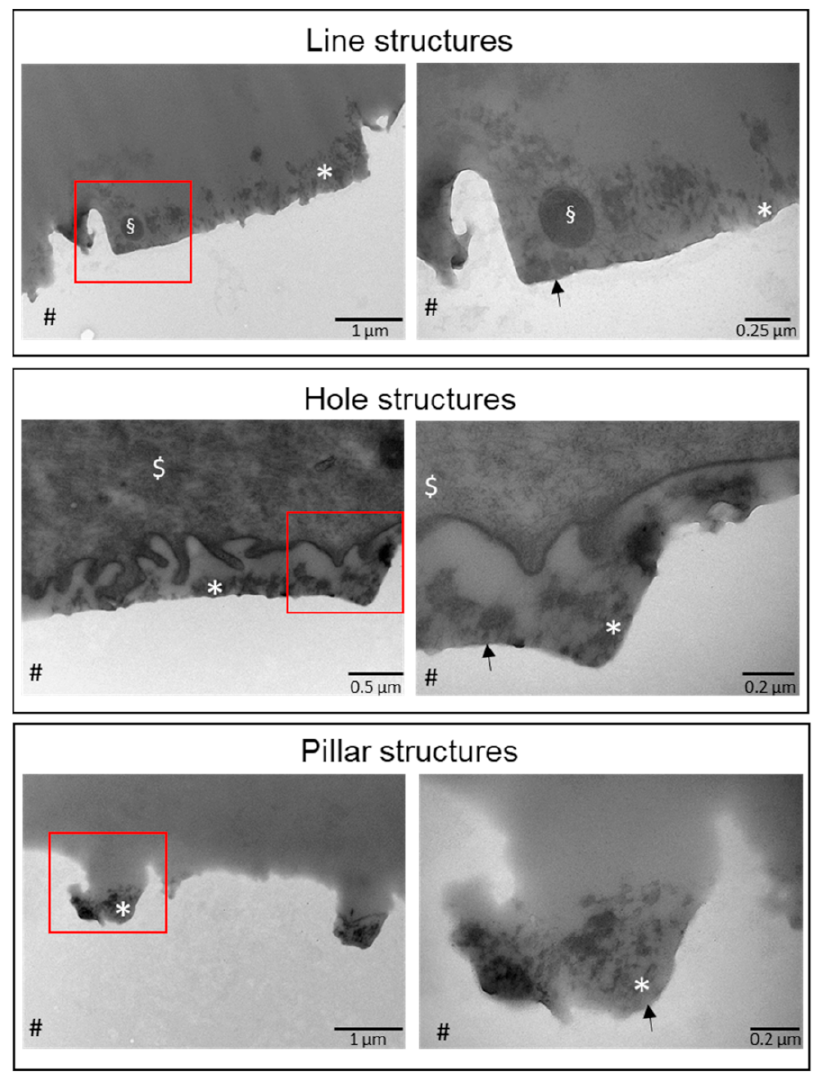
Figure 6. TEM images of specimens exposed to the oral cavity. Specimens made from PFPE containing lines, holes, or pillars were exposed to the oral cavity for 8 h. TEM images were prepared from the probes within the central area. Images on the left side show smaller magnifications while images on the right side depict larger magnifications of the area, indicated by a red square. # denotes the PFPE side. The whole surface was covered by a basal pellicle layer (arrow), however, globular and granular structures are, to the most part, only visible within the recessed areas (*). Additionally, bacteria (§) or epithelial cells ($) can be